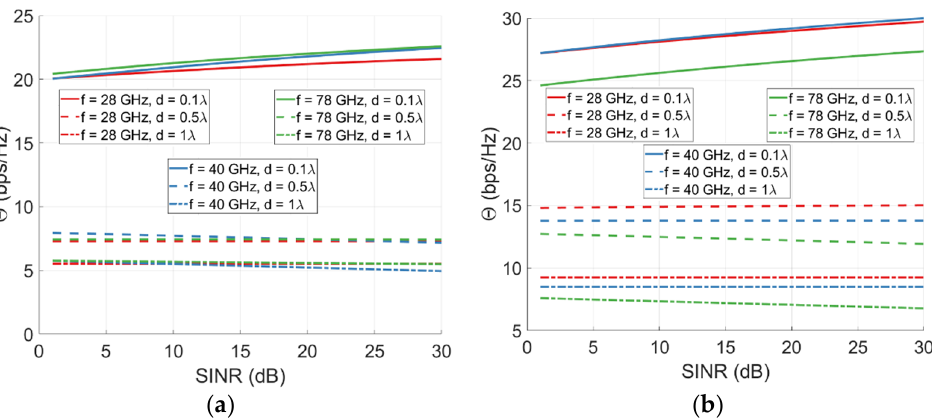
Figure 4. Distance to the spectral efficiency theoretical limit for three frequencies (28 GHz, 40 GHz and 78 GHz) and three TX/RX antenna spacing (λ/10, λ/2 and λ) for several SINR values in a D-MIMO (50 × 10). ( a ) UMa scenario and ( b ) UMi scenario.